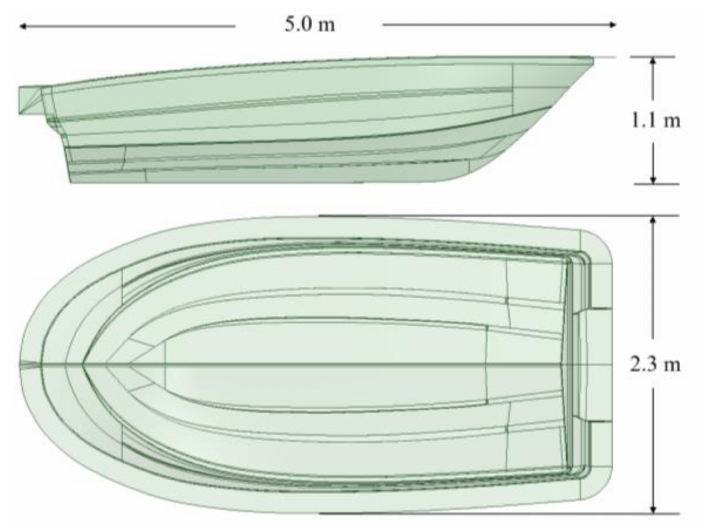
Figure 4. The dimension of boat